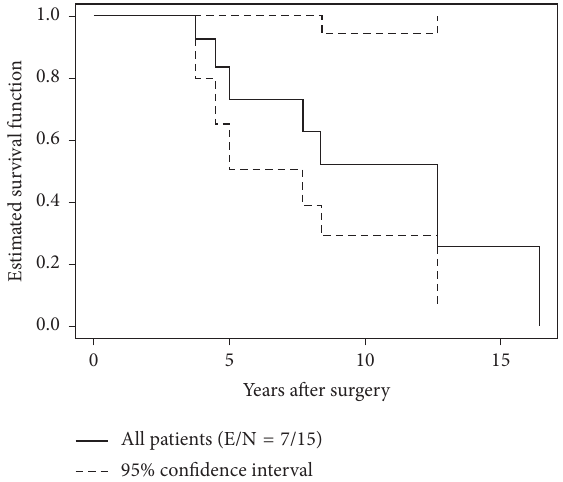
Figure 2: Recurrence-free survival. Note that two patients expe- rienced recurrence or death beyond 10 years from initial resection.